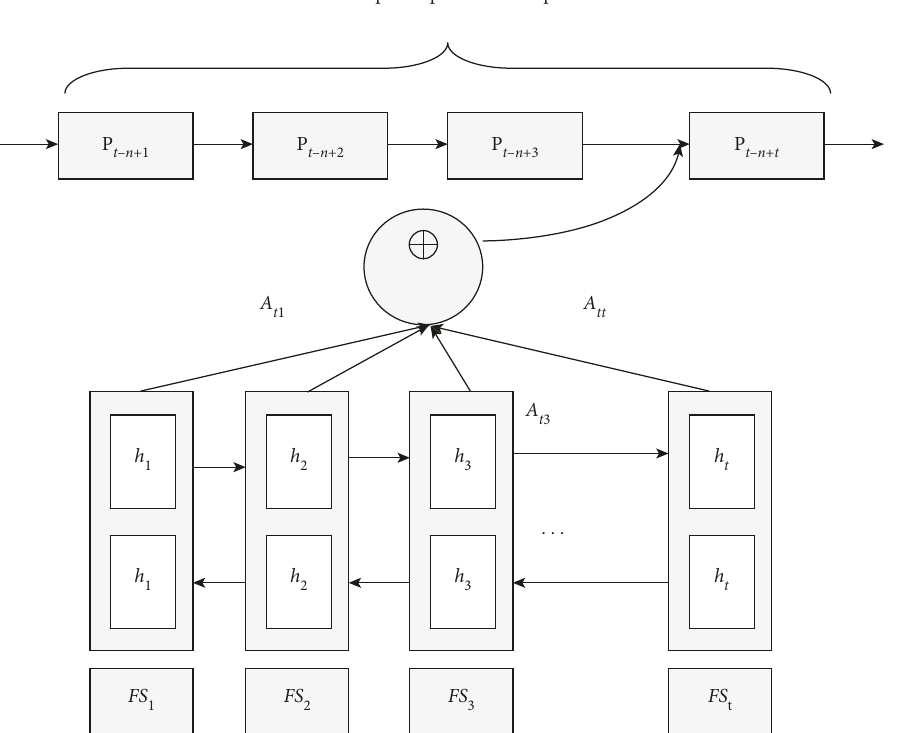
Figure 3: Structure of Attention-oriented Long Short-Term Memory-based Wind Power Prediction